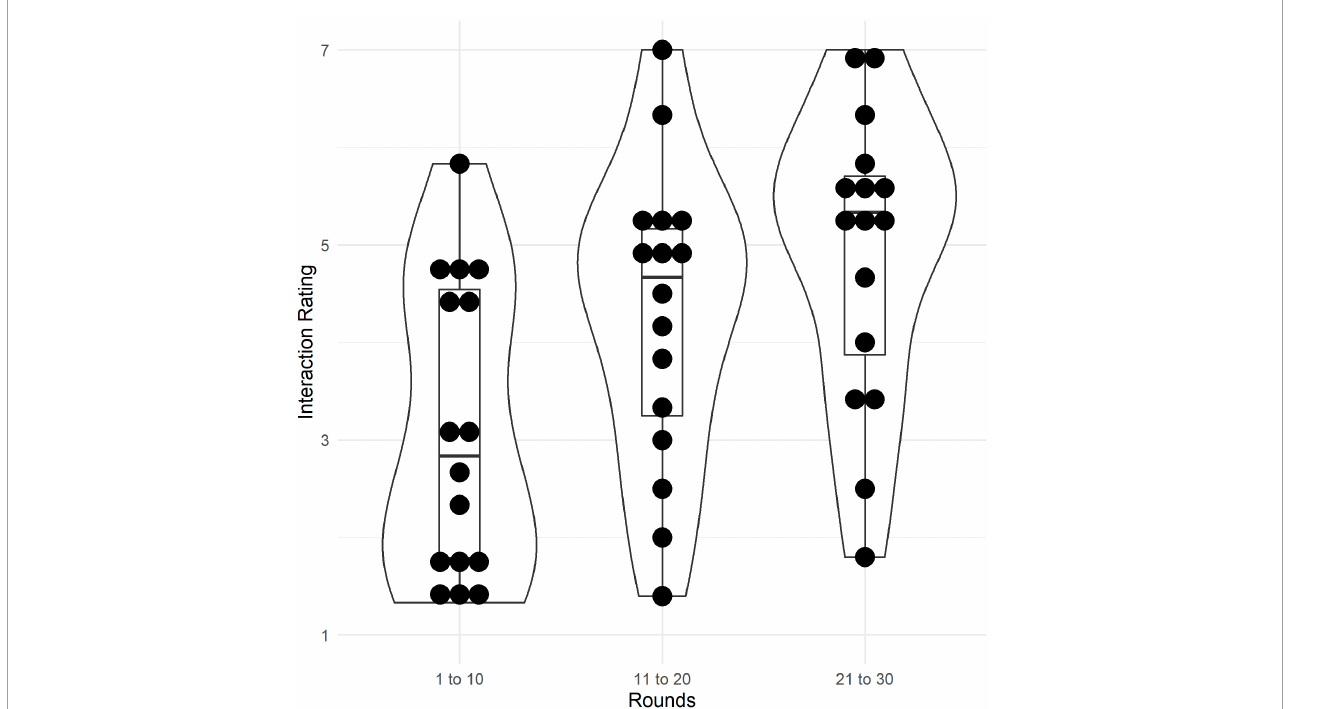
FIGURE6 Ratings of interactivity (retrospective self-report) during the first (round 1–10), second (11–20), and last third (21–30) of the game (7-point Likert scale). Violin plots show density distributions of ratings. Boxes represent the interquartile range, the thick line in the box represents the median, whiskers represent the range of data, dots represent raw